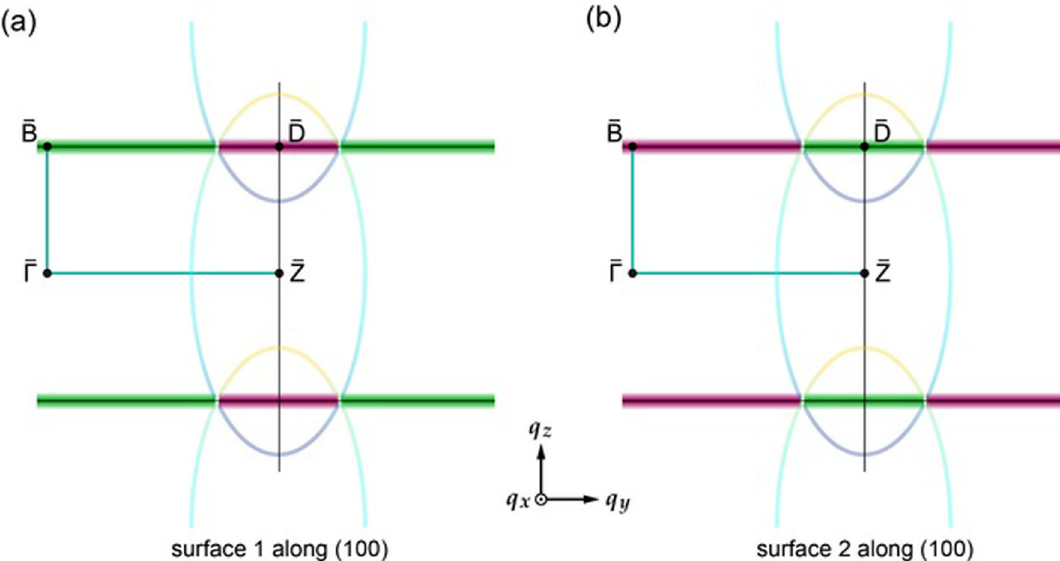
Fig. 5 Zak phase analysis. Zak phase of a surface 1 and b surface 2 along the (100) direction. The purple and green shaded areas correspond to the total Zak phase γ = 2 π and γ = 0,